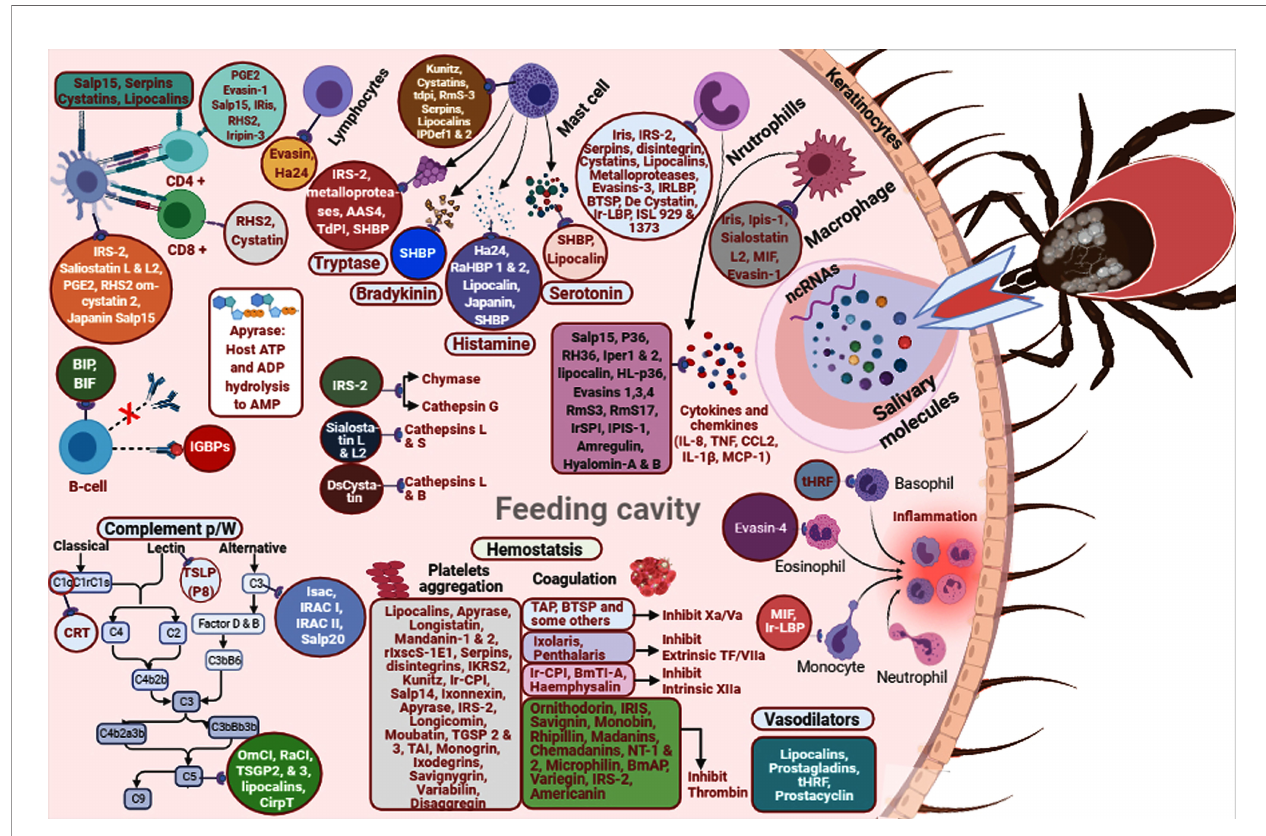
FIGURE 1 | A diagram of tick salivary components involved in invasion of host